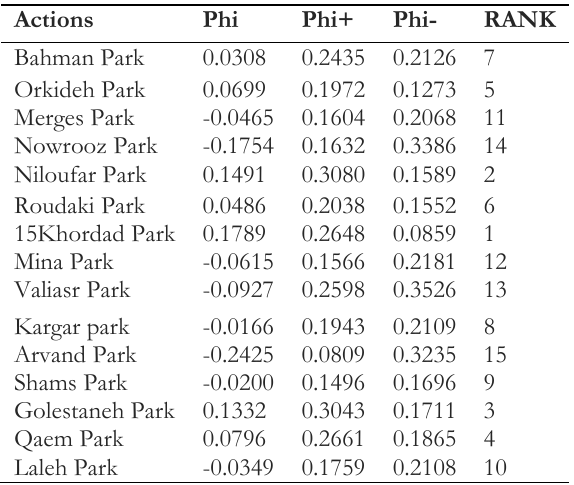
Table 5. PROMETHEE ranking